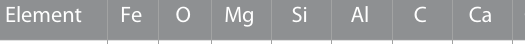
TABLE 1 X-Ray Fluorescence results of pristine magnetite.